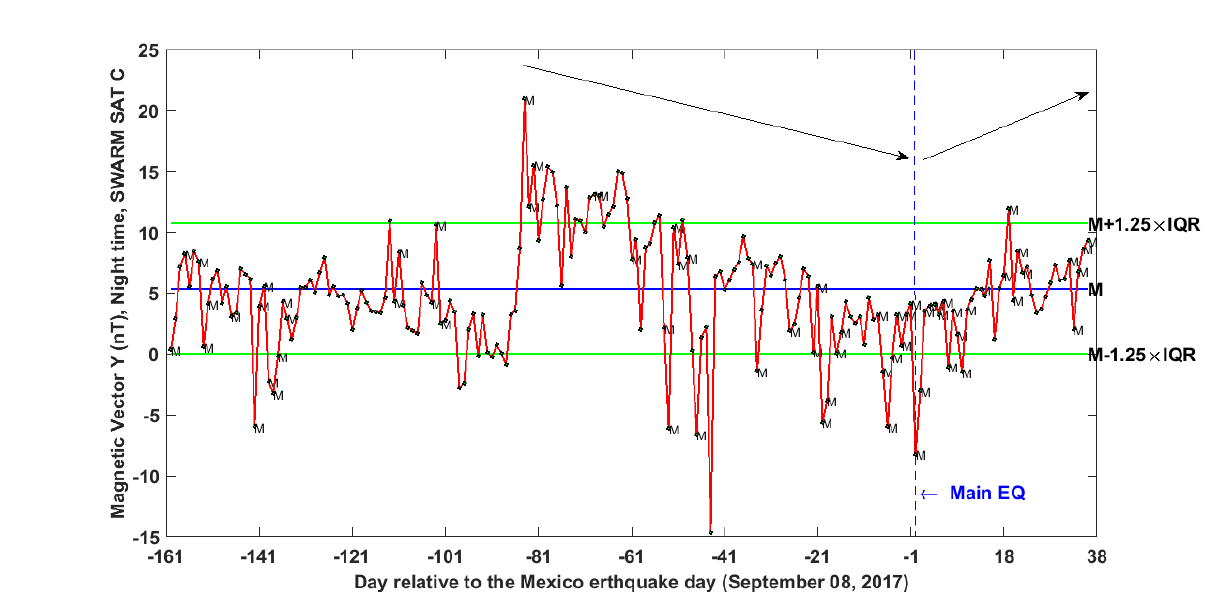
Fig. 3. Same as Fig. 2 but the y-axis represents the night time vector Y magnetic field median values for each day measured by Swarm